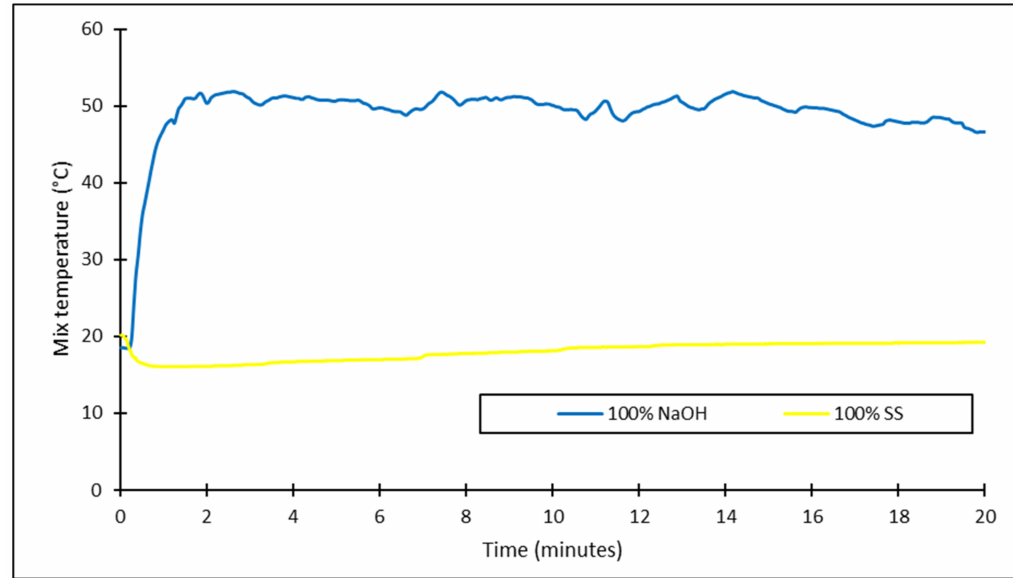
Figure 12. Temperature variation during agitation of the geopolymer